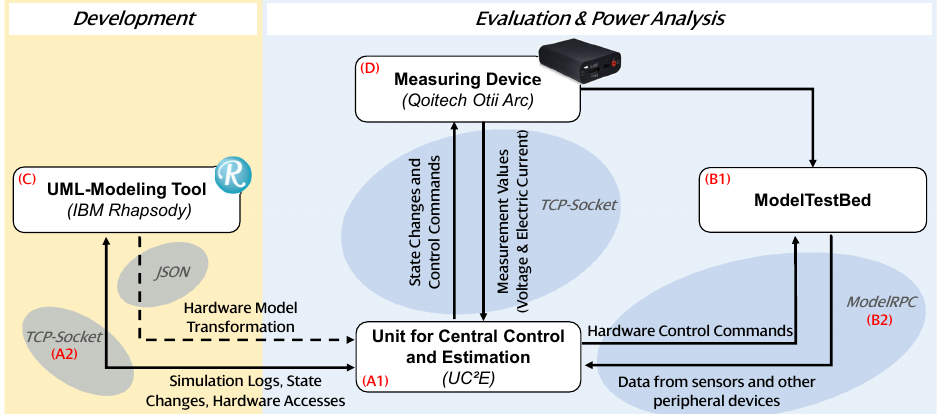
Figure 13. DPA concept using IBM Rhapsody as model-driven development tool and Qoitech Otii Arc as measuring device. Solid arrows indicate connections used during the simulation and evaluation, while dashed arrows describe manual steps, which have to be performed once before